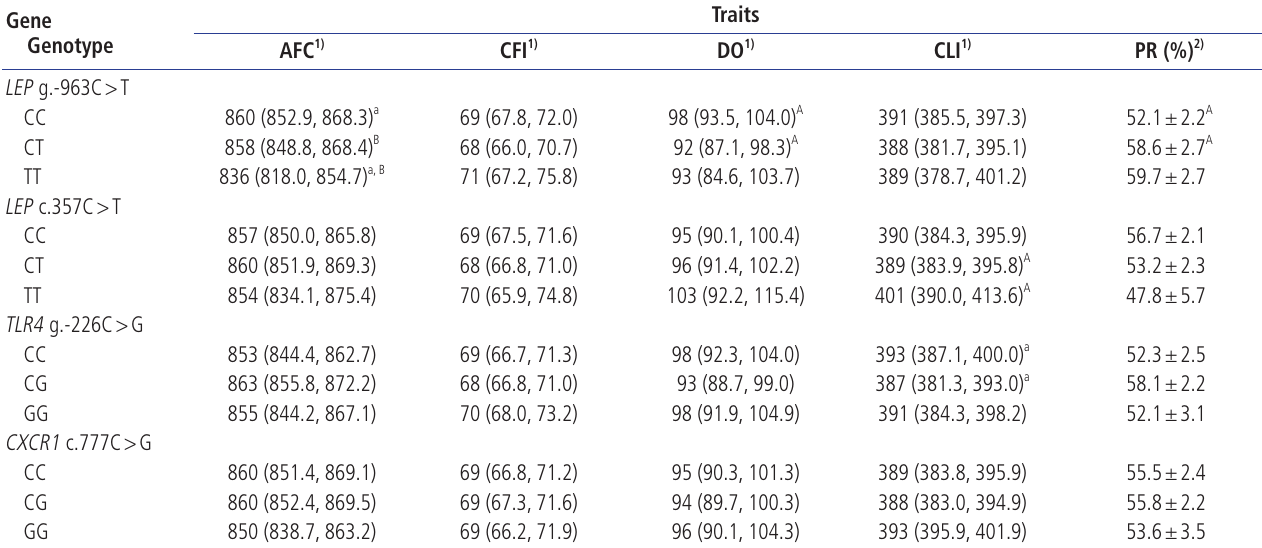
Table 3. SNP associations with fertility traits in repeated measurements analysis Gene